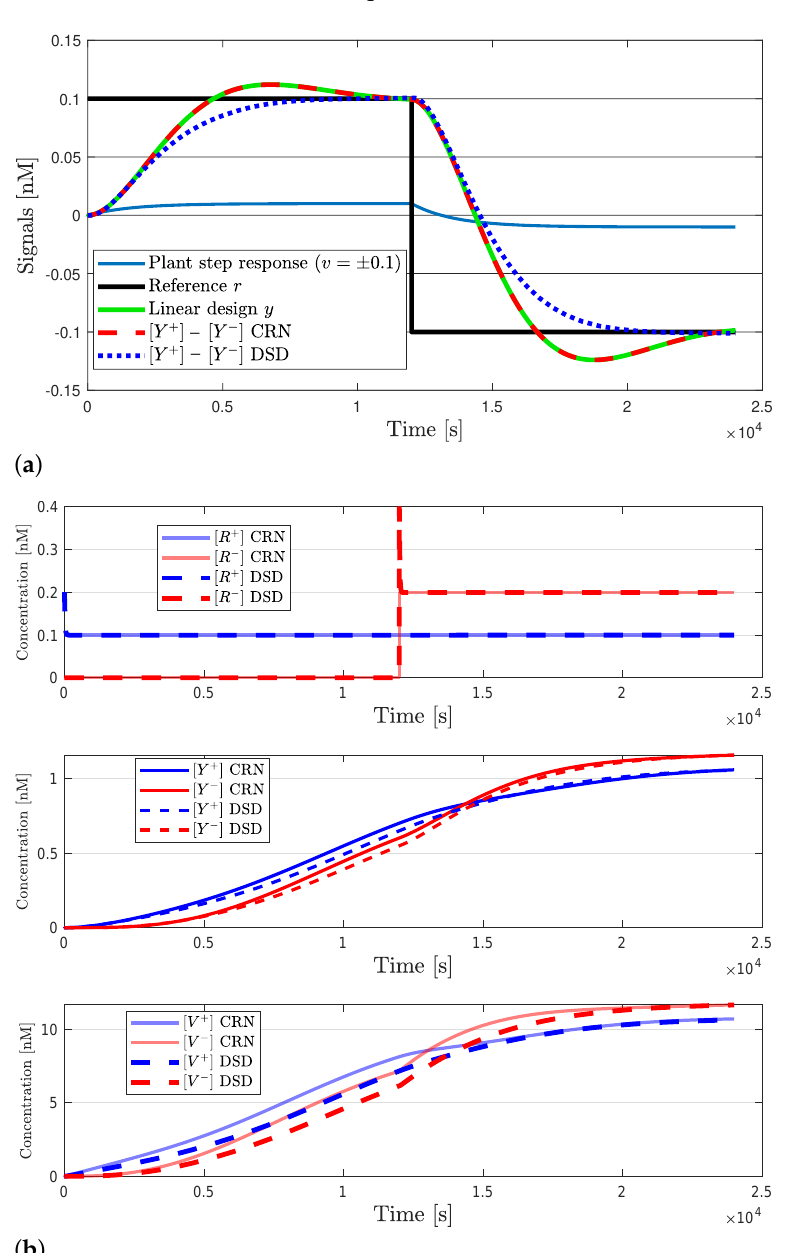
Figure 11. The integral control (Example 3) simulation results: ( a ) output y for the step response of the open-loop plant, closed-loop dynamics, the MAK from the CRN and DSD reactions; ( b ) concentrations in both the CRN and DSD